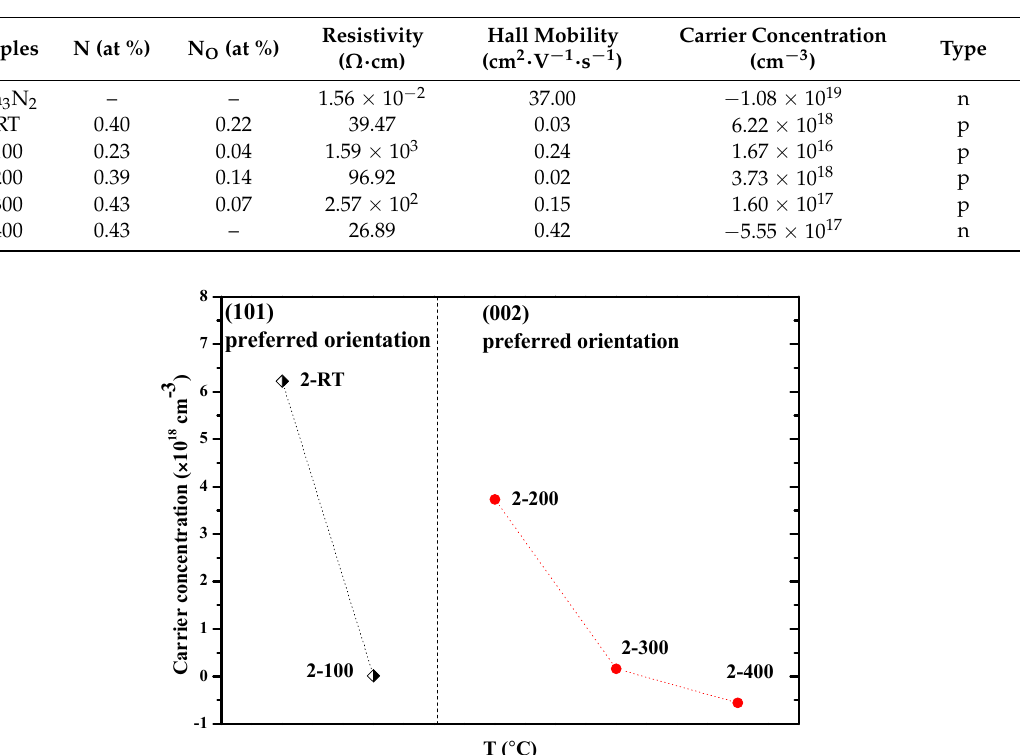
Table 1. The electricity property of the as-grown 2-Zn 3 N 2 and oxidized ZnO:N films.